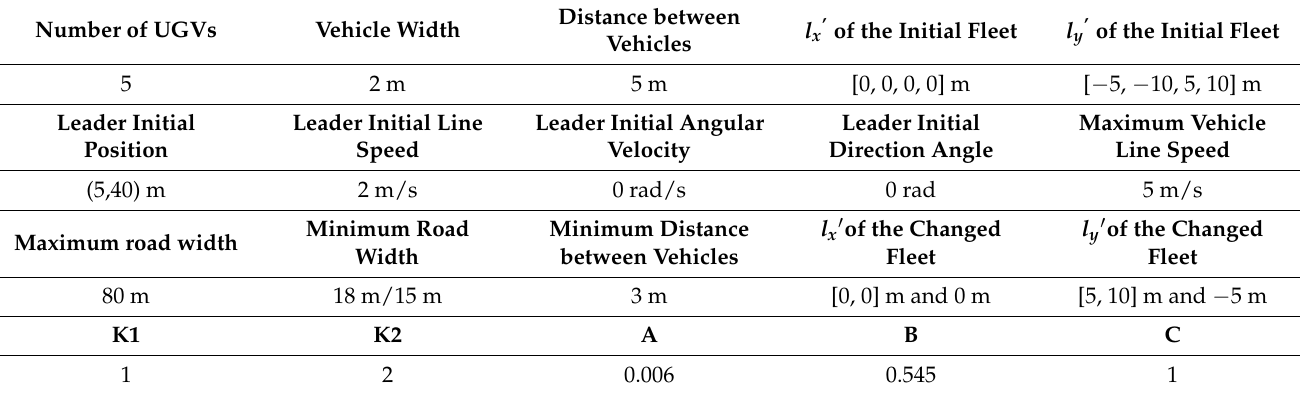
Figure 26 details the map in case of a road obstacle and the result of the fleet’s path under this map.